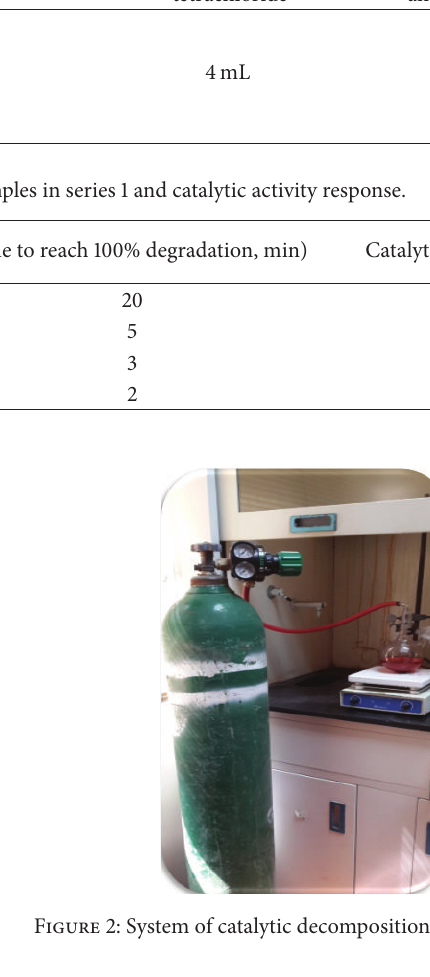
Table 1: Different amounts of iron nitrate, cerium ammonium sulfate, and titanium tetrachloride. Sample